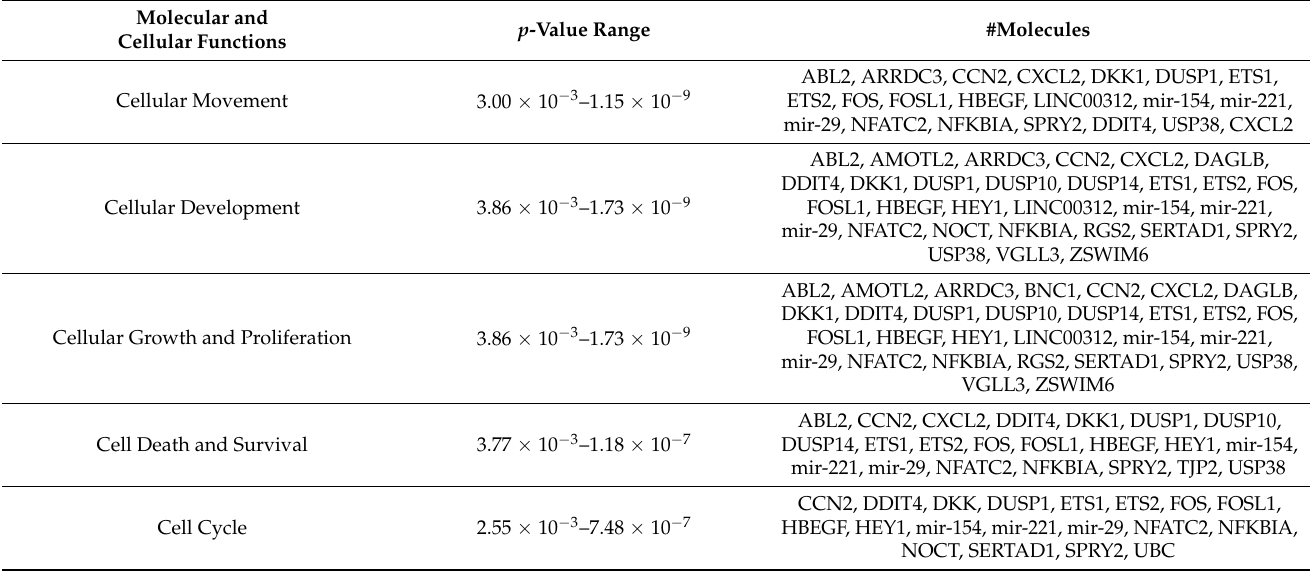
Table 2. GO analysis of the DNA microarray results.